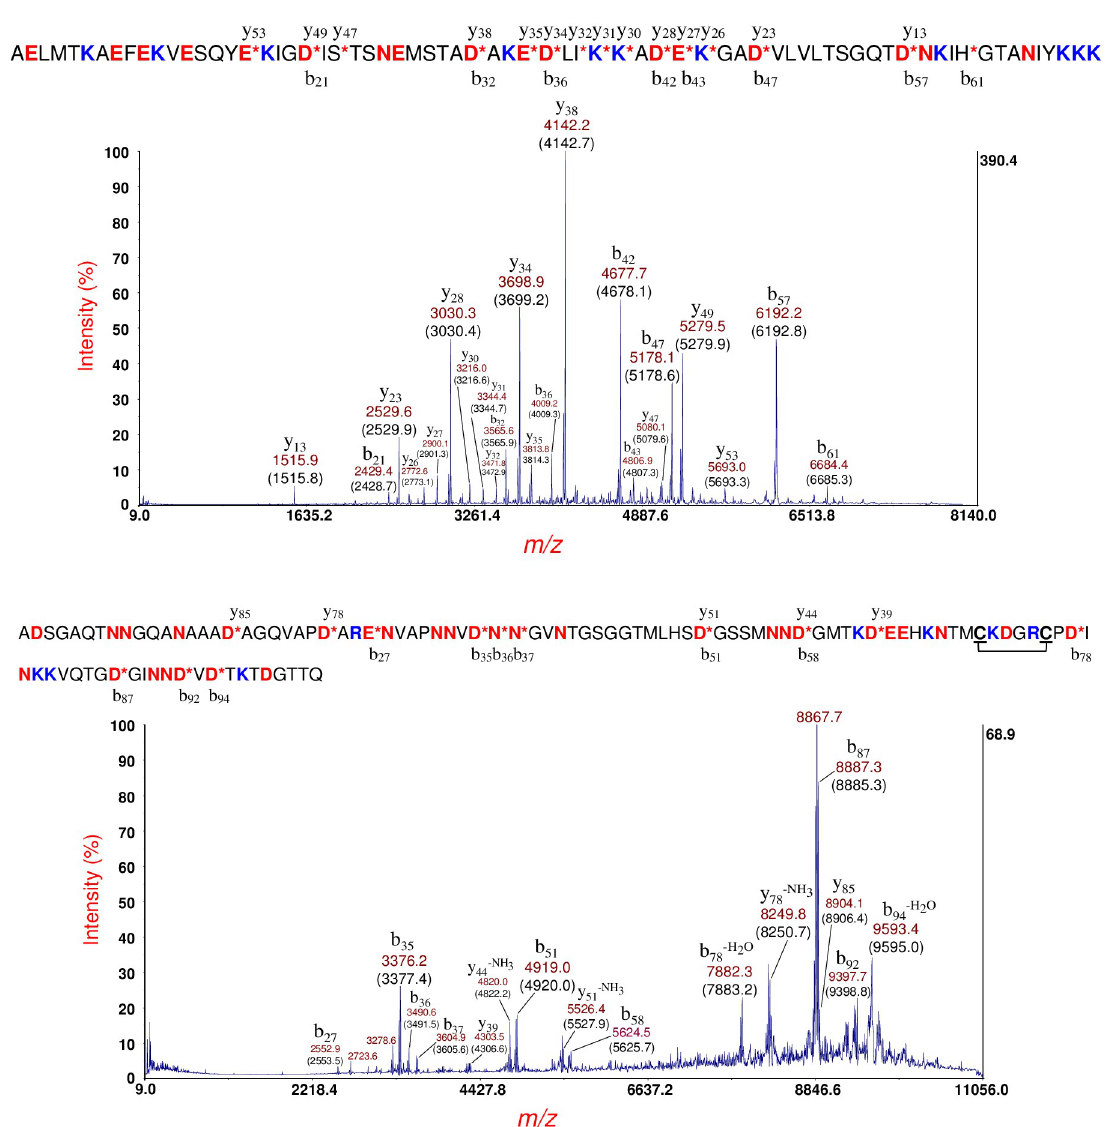
Fig 9. Top panel: MS/MS of the putative YahO protein ion at m/z 7708 [M+H] + (Fig 8, top panel). The mature YahO sequence without its signal peptide is shown above. Bottom panel: MS/MS of the putative YbgS protein at m/z 10469 [M+H] + (Fig 7, top panel). The protein sequence identification is shown above: YbgS-like protein, hypothetical protein (O3K_17905, AFS75454.1). A 24-residue signal peptide has been removed in the mature sequence. An intramolecular disulfide bond is symbolized by a connecting line between two C-residues